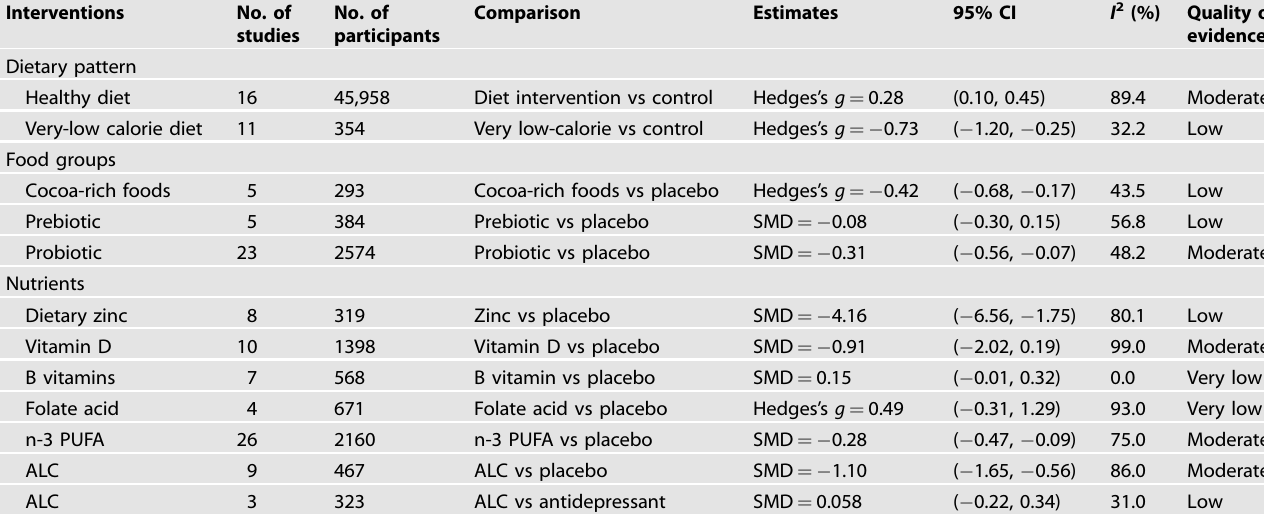
Table 2. Summary estimates with 95% con fi dence intervals and quality of evidence for associations between dietary intervention and the treatment of